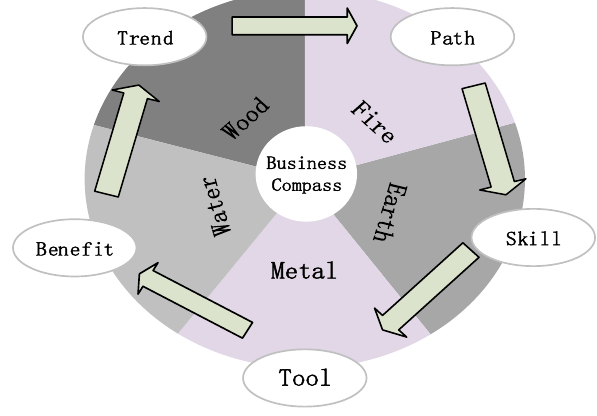
Figure 1. Business compass model.